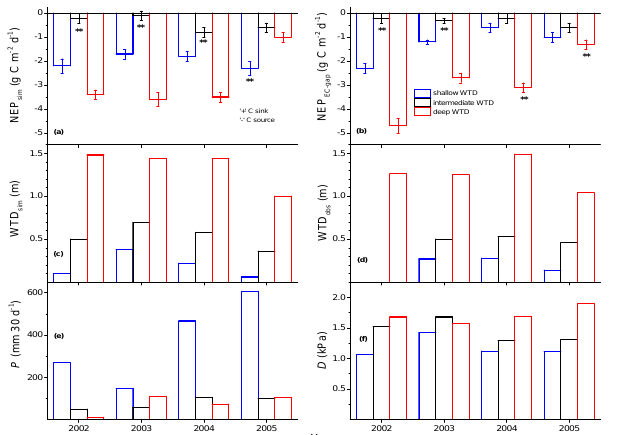
∗ dr=drained simulation; undr=undrained simulation (Sect. 2.2.6); WTD=water table depth, values are the annual means of simulated WTD data in Fig. 9, positive values represent WTDs below hollow surface and the negative value represents WTD above the hollow surface; GPP=gross primary productivity; R a = autotrophic respiration; NPP=net primary productivity (NPP=GPP − R a ) ; R h =heterotrophic respiration; R e =ecosystem respiration; and NEP=net ecosystem productivity (NEP=NPP − R h ) .